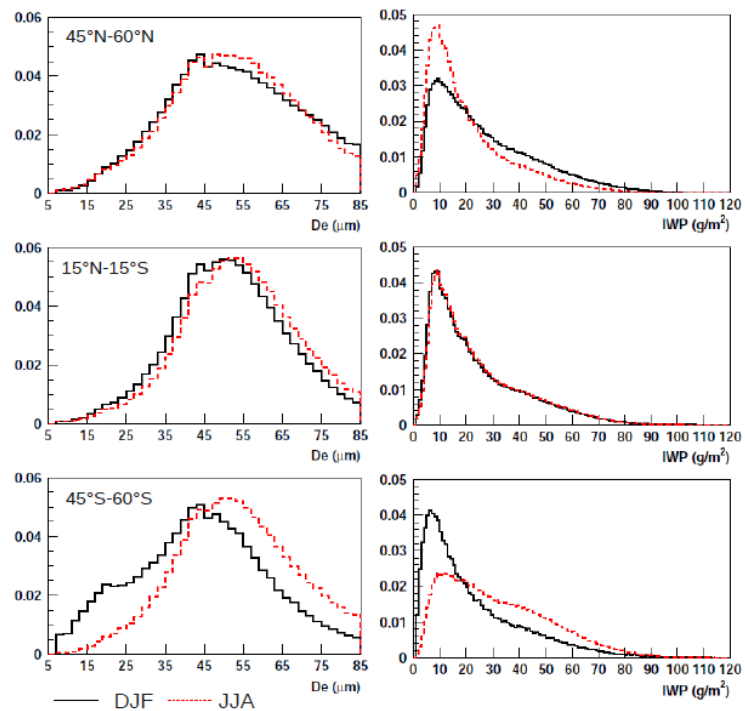
Fig. 11. Normalized frequency distributions of D e (left) and IWP (right) of ST-HICs for three latitude bands. Boreal winter and boreal summer are represented with black and red lines, respectively. Statistics is over the period 2003–2009.